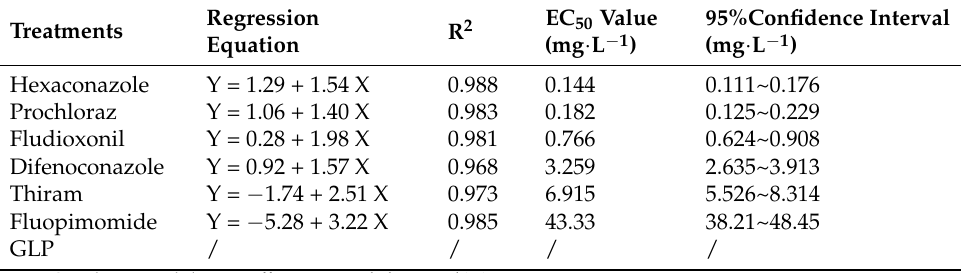
Table 3. In vivo assays test of GLP and fungicides on Drechslera sorokiniana . Treatments